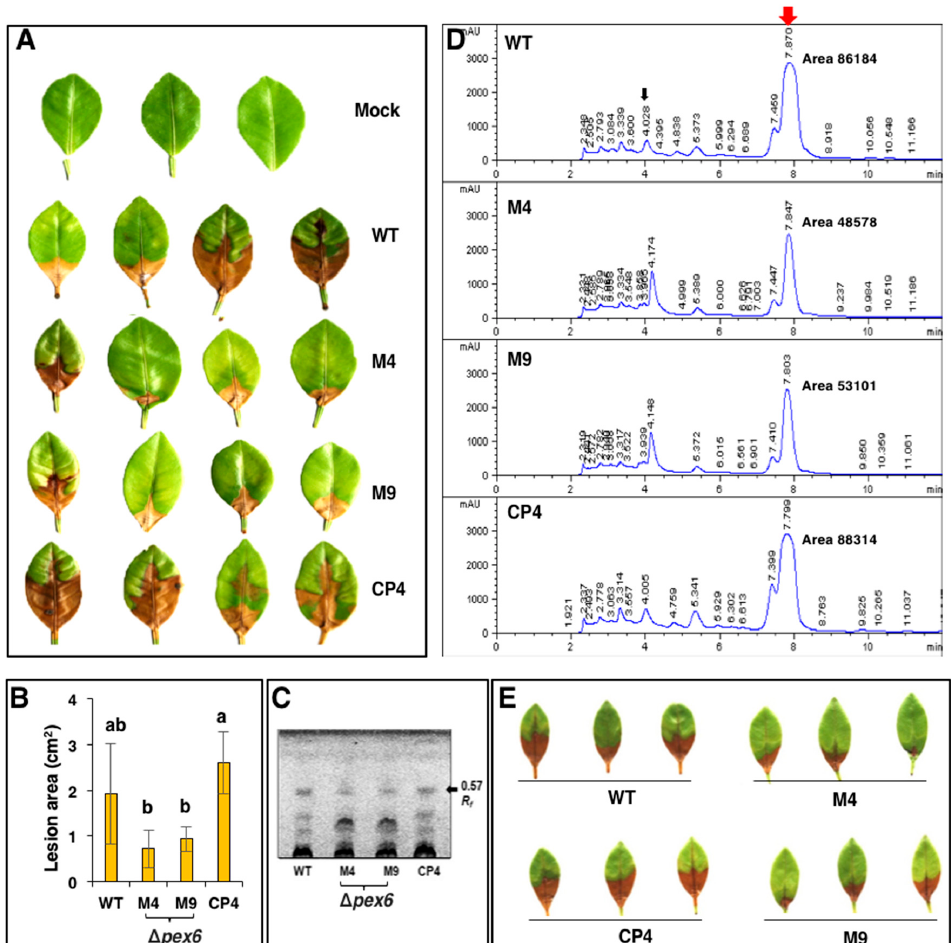
Figure 9. Pex6 deficiency impacts toxin production in the tangerine pathotype of A. alternata . ( A ) A